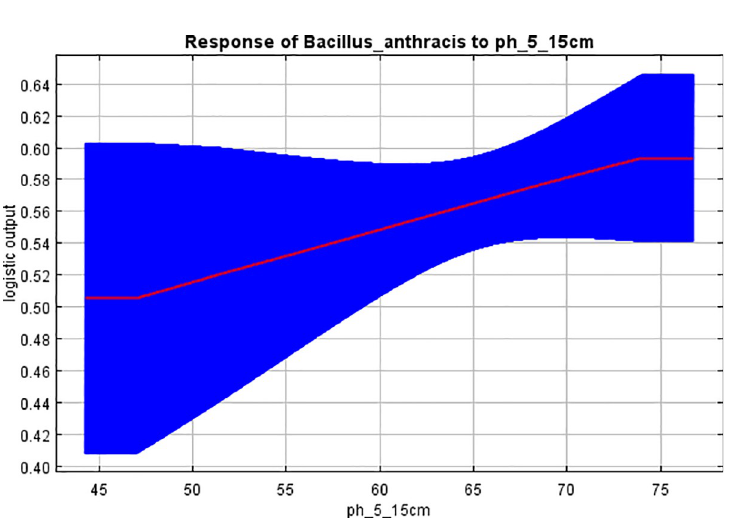
Fig 7. Marginal response curve showing how the predicted suitability for anthrax presence changed with varying levels of soil pH. Probability for anthrax spore survival increases with increasing levels of soil pH. Covariate values for pH are divisible by 10 to derive actual pH